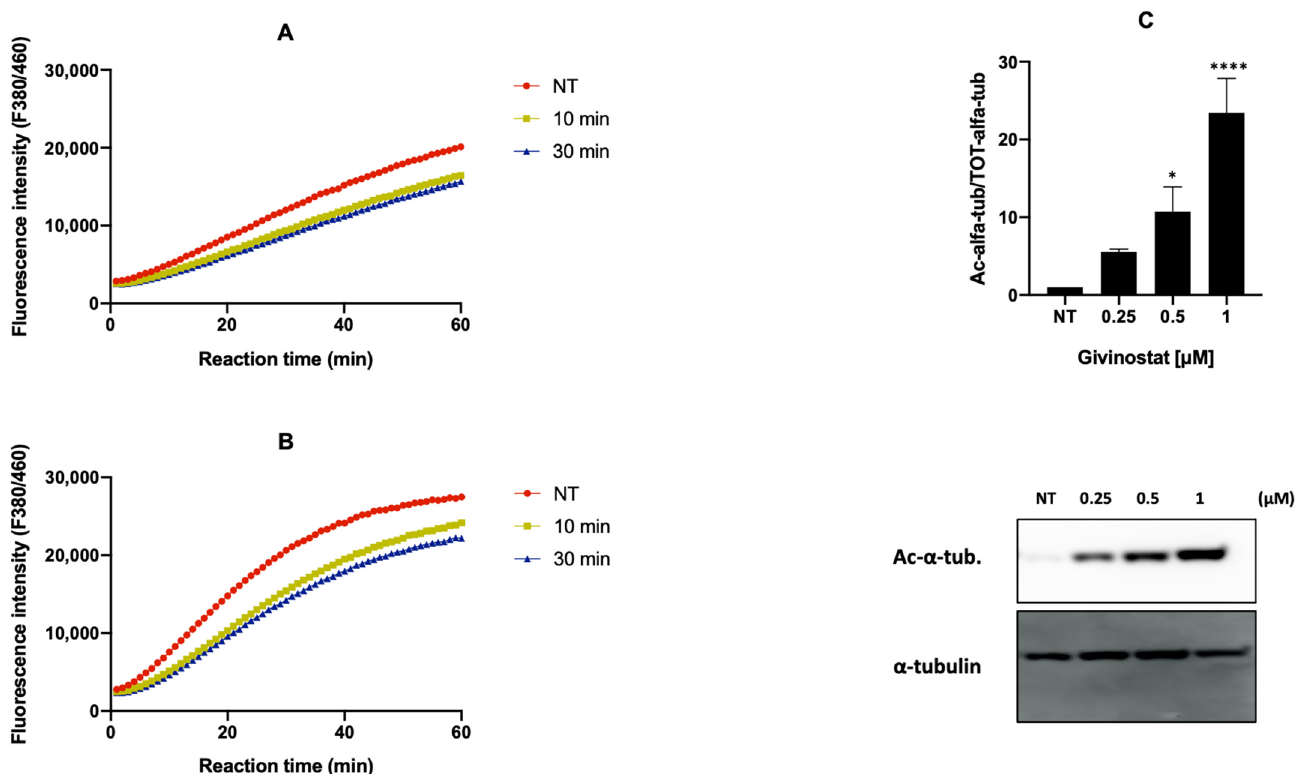
Figure 5. Percentage of HDACs activity in the Gli36 ∆ EGFR-2 cell line treated with LIP/m-GIV 0.5 µ M in the cytoplasm ( A ) and nucleus ( B ). After each selected time, cells were lysed, and cell fractions were extracted. HDAC activity was established through an HDAC activity assay based on ligand fluorescence. ( C ) The effect of LIP/m-GIV on α -tubulin acetylation. WB showing the protein levels of acetylated- α -tubulin (Ac- α -tub.) and total α -tubulin in Gli36 ∆ EGFR-2 cells without treatment (NT) or treatment with LIP/m-GIV in various concentrations. The graph shows the quantifications of Ac- α -tub. in three independent experiments. Total α -tubulin was used as a normalization protein. *, p < 0.05; ****, p < 0.0001, one-way ANOVA, Tukey’s multiple comparisons test.